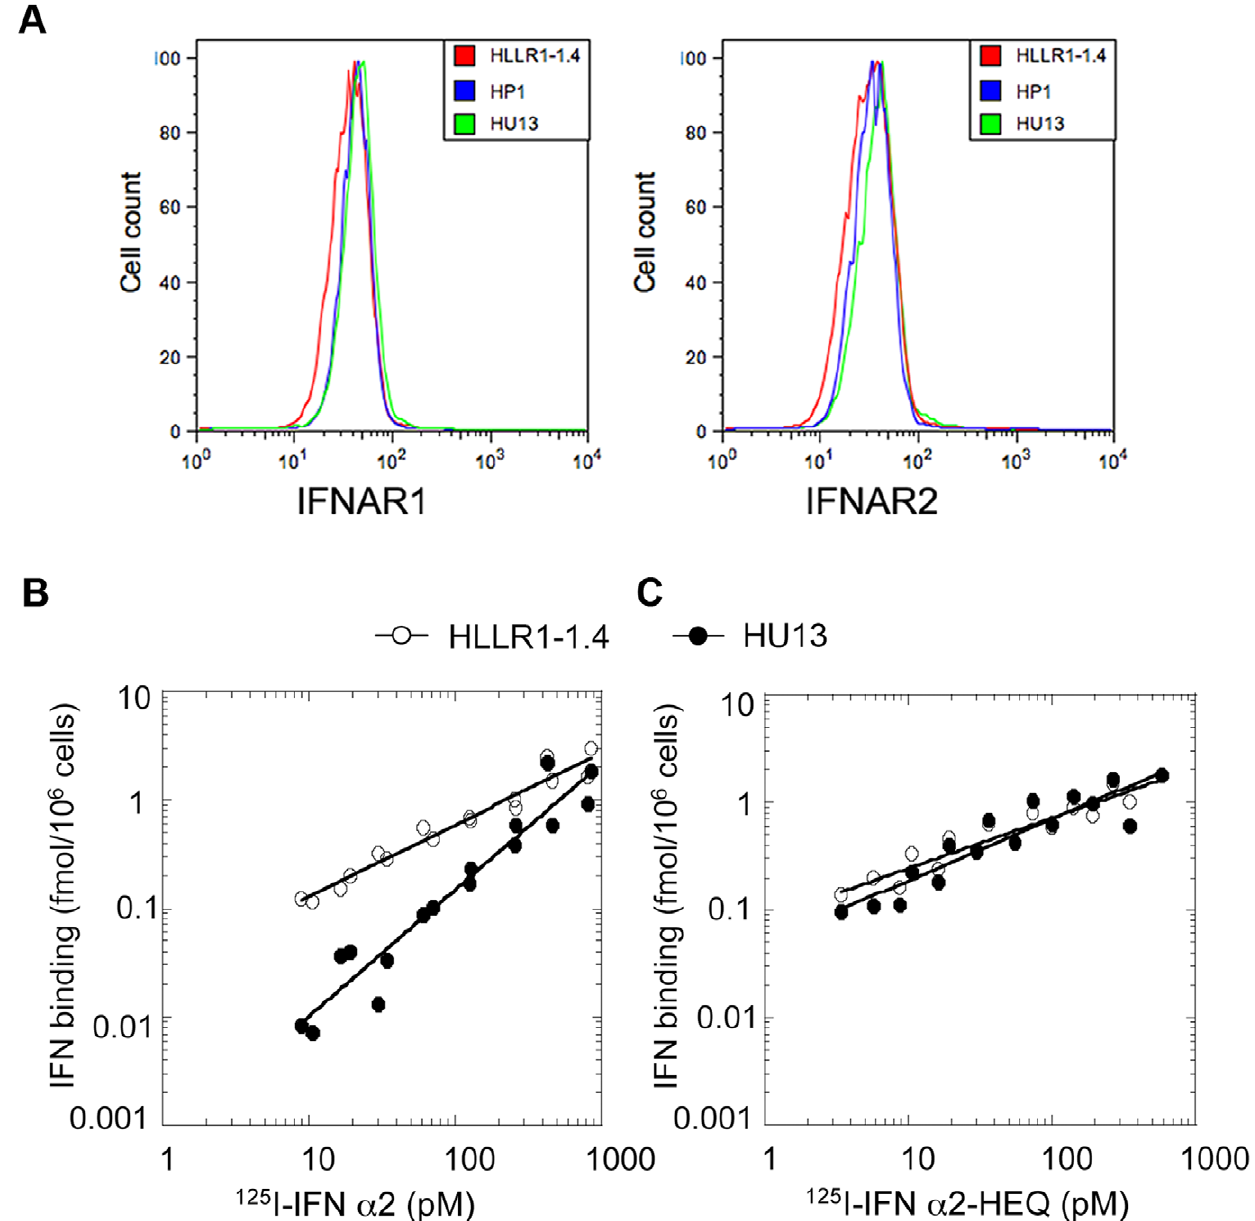
Figure 7. Cells expressing USP18 are defective in IFN a 2 binding. (A) Cell surface levels of IFNAR1 (left) and IFNAR2 (right) in parental HLLR1- 1.4 cells, USP18-expressing clone HU13 and control clone HP1was determined by FACS. Binding of 125 I labelled IFN a 2 (B), or IFN a 2-HEQ (C) at 37 u C for 1 hr on HLLR1-1.4 cells (closed circles) and clone HU13 (triangles). doi:10.1371/journal.pone.0022200.g007 PLoS ONE |